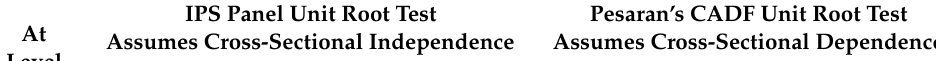
Table 5. Panel unit root tests (full